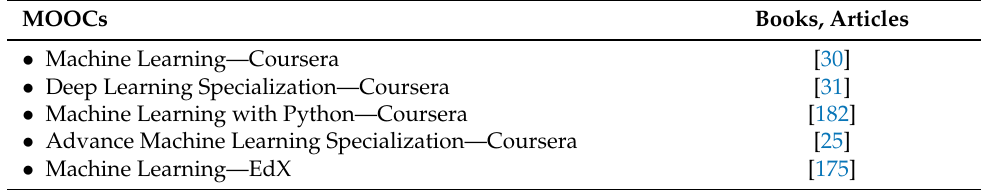
Table 8. Sources for an introduction to the fundamentals of ML